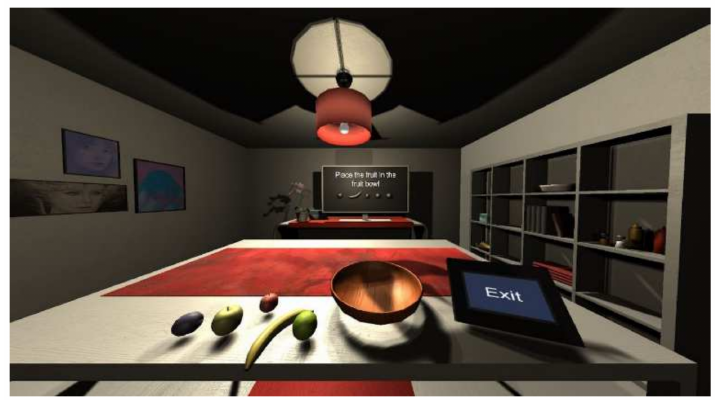
Figure 2. Fruit bowl